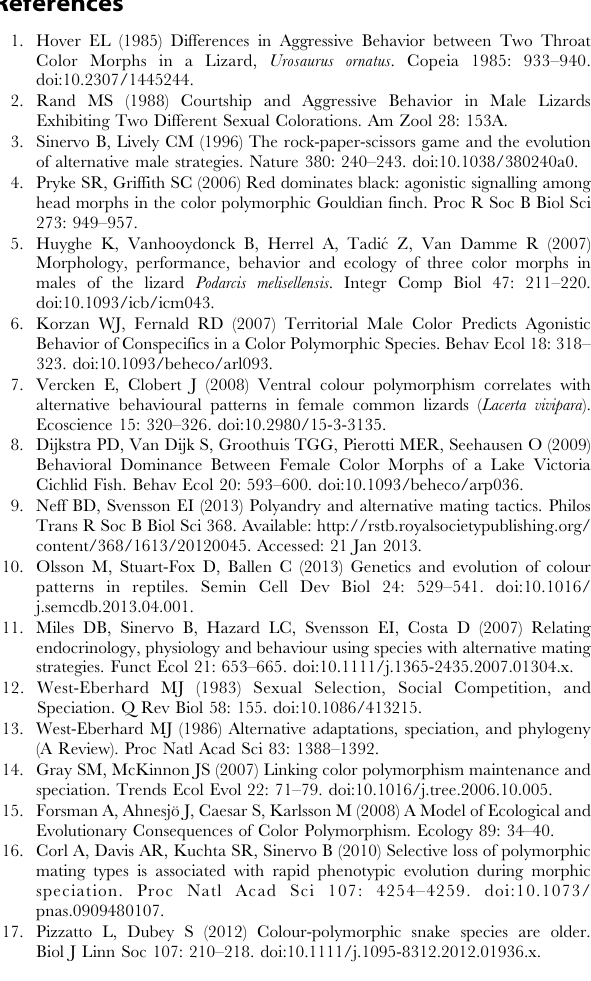
Figure S1 Female discrimination differential (LS means, error bars show 95% CI) versus female throat color morph. We found no effect of female color morph on discrimination differential. Figure S2 Female discrimination index (LS means, error bars show 95% CI) did not differ significantly between dosage effect and identical morph SC